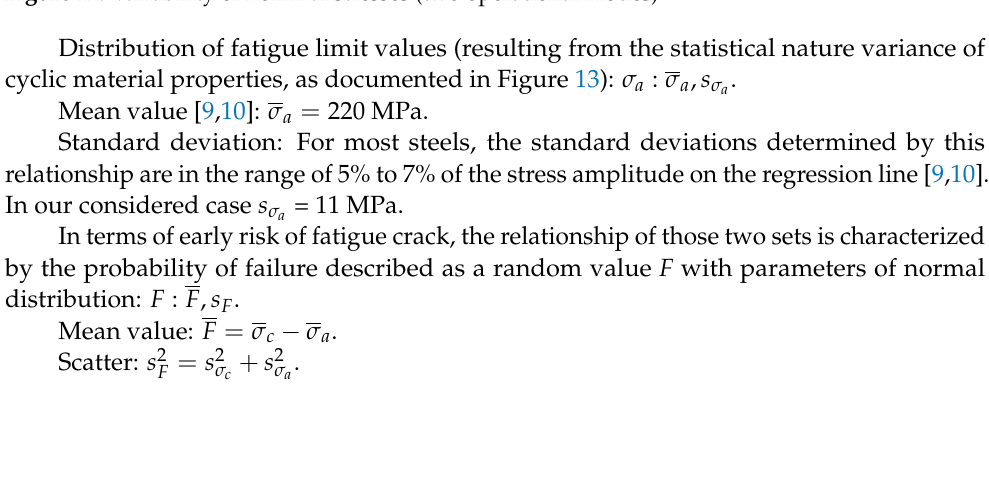
Figure 12. Variability of nominal stresses (two operational modes).